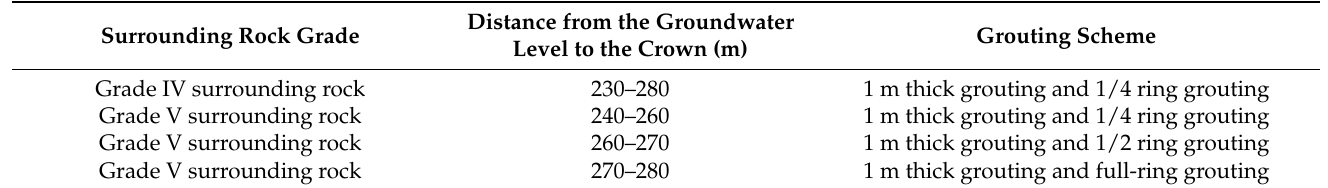
Table 2. Grouting schemes under different buried depths, surrounding rock grades, and grouting ring